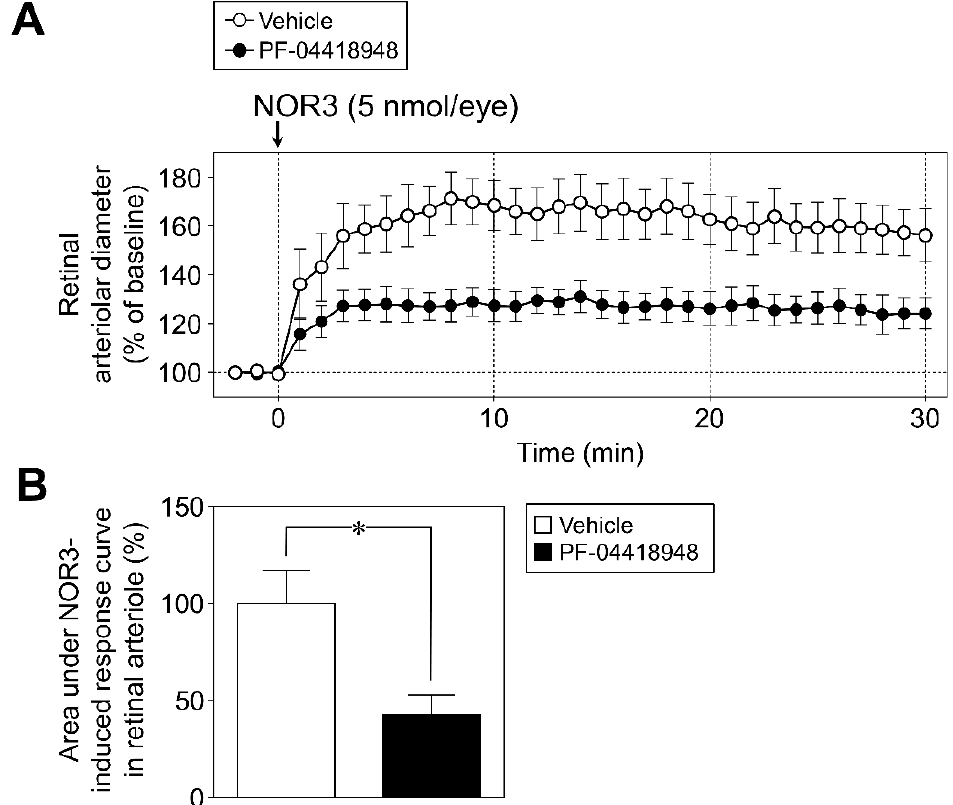
Figure 2. Involvement of prostanoid EP 2 receptors in intravitreal injection of NOR3-induced retinal arteriolar dilation in rats. ( A ): The effect of PF-04418948 (20 nmol/eye), a prostanoid EP 2 receptor antagonist, on changes in retinal arteriolar diameter induced by intravitreal injection of NOR3 (5 nmol/eye). ( B ): Bar graph shows the integrated area under the NOR3-induced response curve in retinal arteriole in vehicle- and PF-04418948-treated groups. Each point or column with a vertical bar represents the mean ± S.E.M. from five to six animals. * p < 0.05.